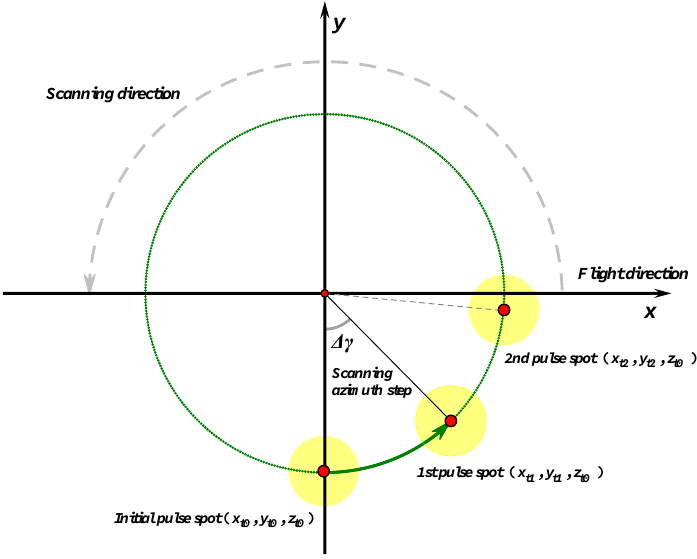
Figure 5. The top view of laser scanning detection.